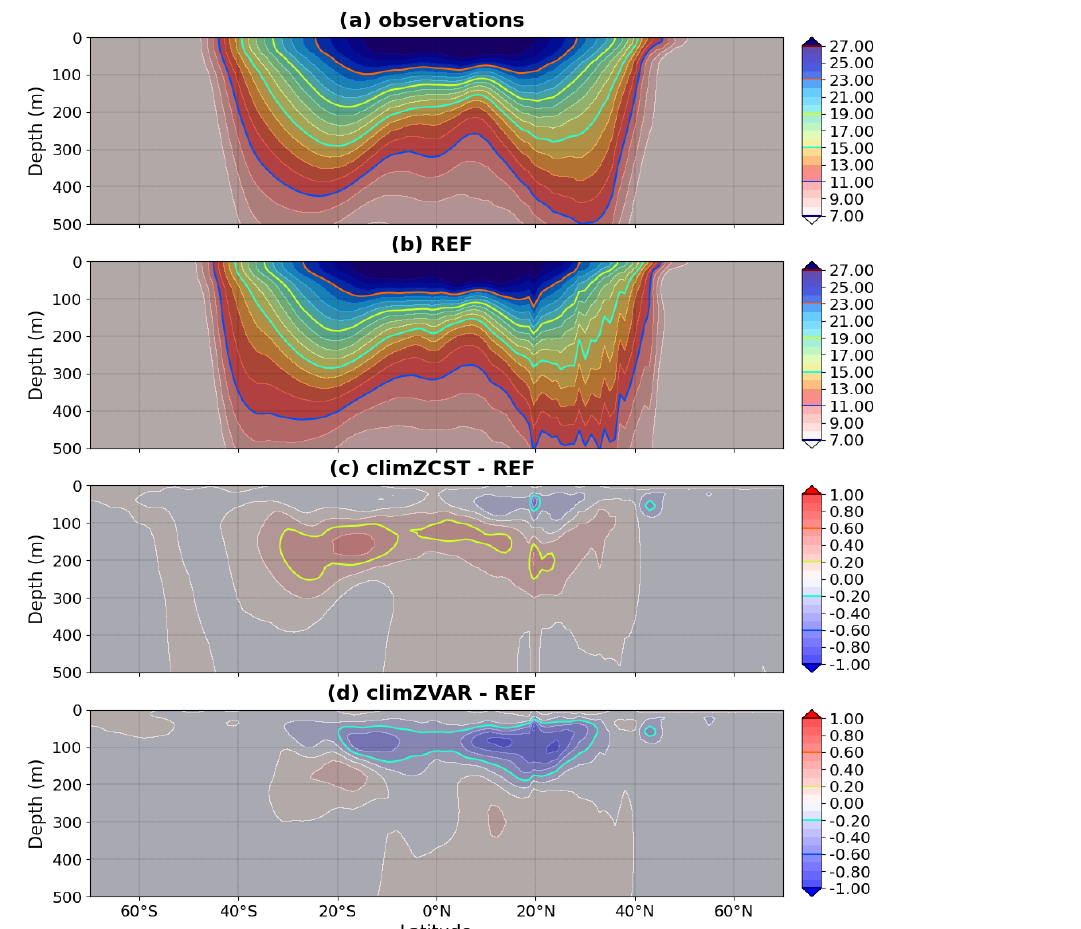
Figure 3. Mean 2009–2018 meridional section of temperature ( ◦ C) averaged over 0–360 ◦ E for (a) observations and (b) REF and its differences in relation to (c) climZCST and (d)